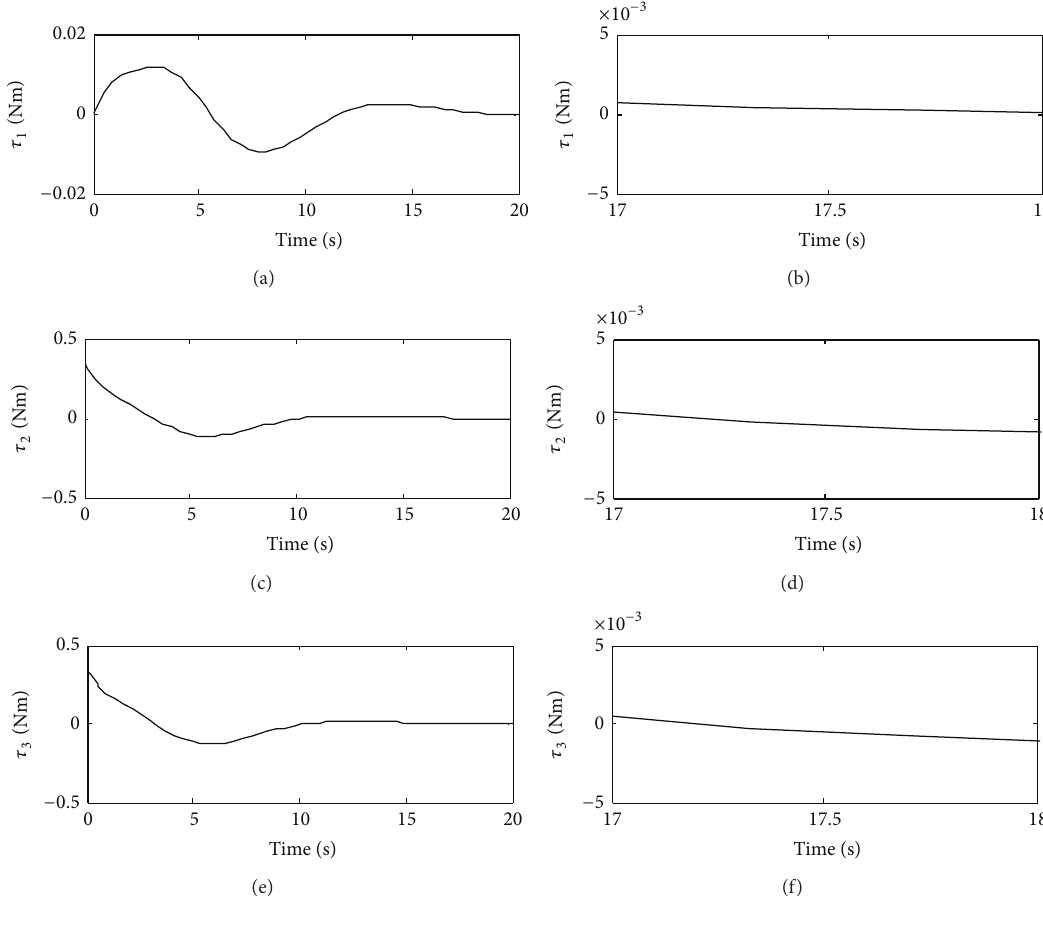
Figure 8: Control torque, 𝜏 = [𝜏 1 𝜏 2 𝜏 3 ]